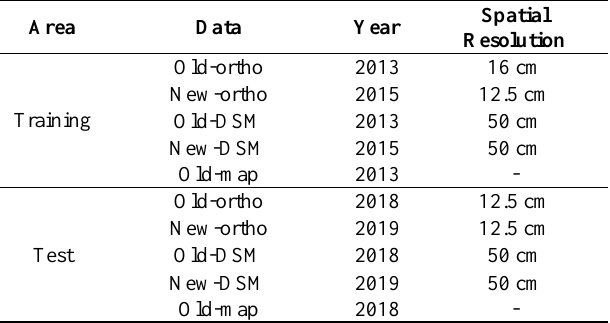
Table 1. Overview of input data